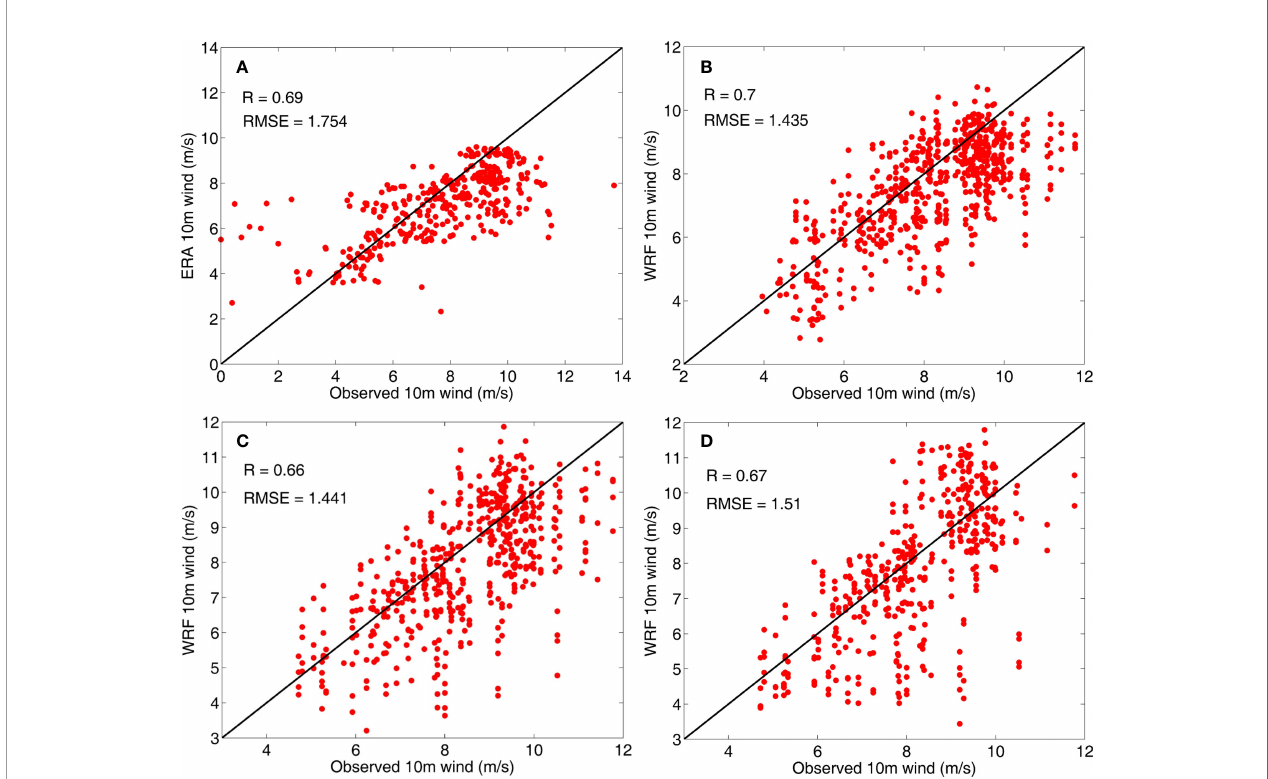
FIGURE 4 | Scatter plot of 10 m wind from buoy observations (shown in Figure 1 , unit: m s -1 ) and (A) reanalysis ERA5, (B) 0 – 24 h, (C) 25 – 48 h, and (D) 49 – 72 h forecasts of WRF-D02 in the EIO (see Figure 1A ). R is the correlation coef fi cient, and RMSE is the root mean square error.